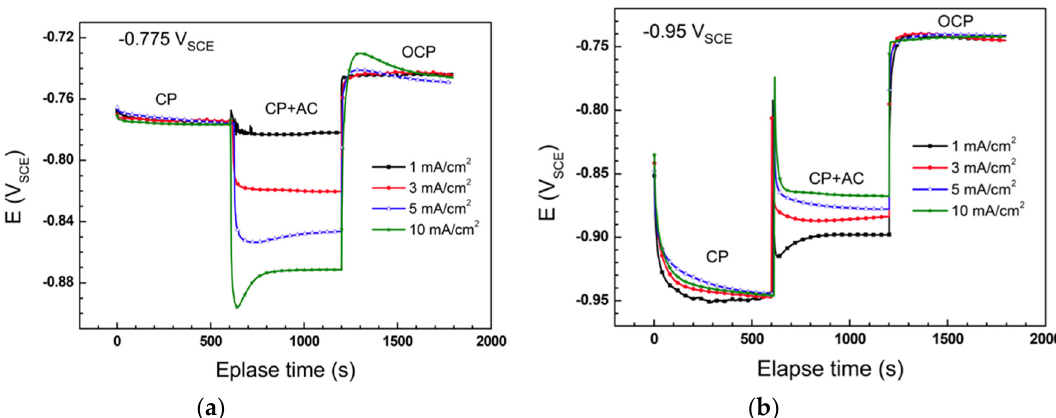
Figure 3. Effect of AC density on DC potential of X70 steel in near-neutral pH bicarbonate solution in cathodic protection condition: ( a ) − 0.775 V vs. saturated calomel electrode (SCE) ( − 0.850 V vs. CSE) ( b ) − 0.95 V vs. SCE ( − 1.02 V vs. CSE). 1 mA·cm − 2 corresponds to 10 A·m − 2 [55].